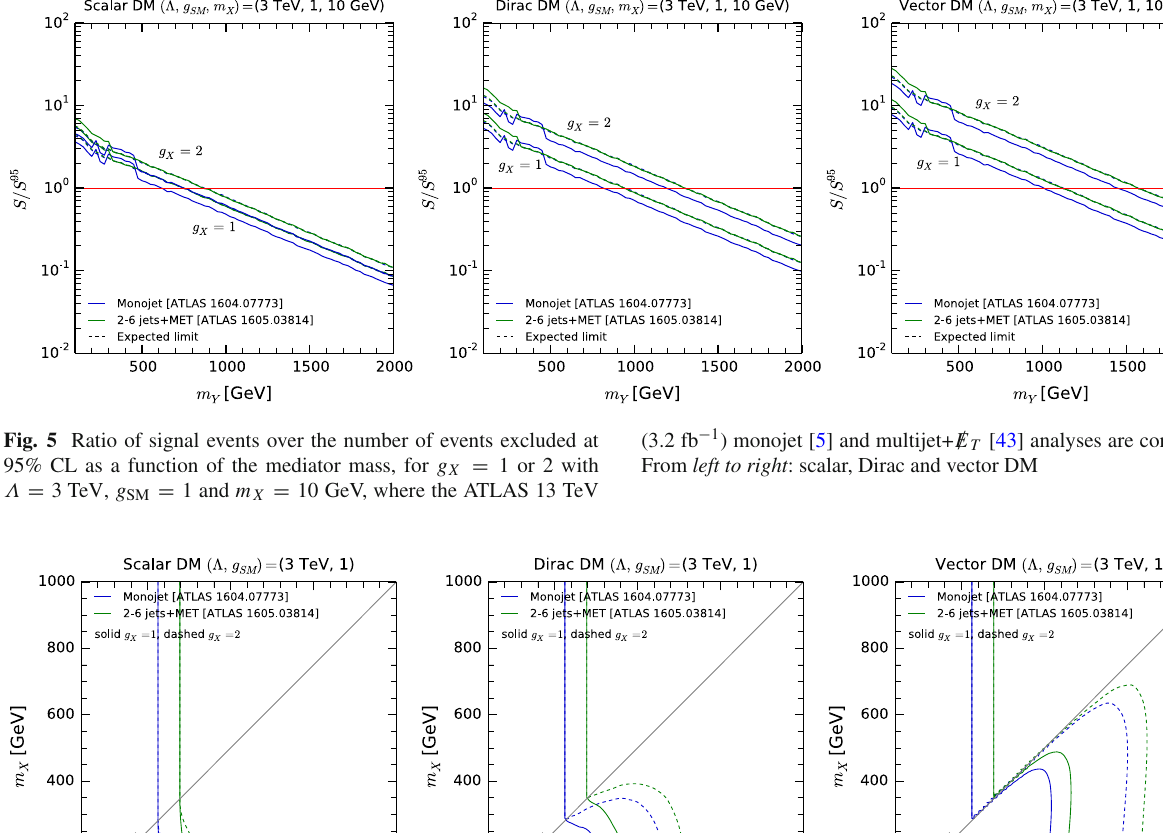
Fig. 6 95% CL exclusion from the ATLAS 13 TeV (3.2 fb − 1 ) monojet [5] and multijet+ / E T [43] analyses in the plane of the DM vs. mediator masses, for g X = 1 or 2 with Λ = 3 TeV and g SM = 1. From left to right : scalar, Dirac and vector